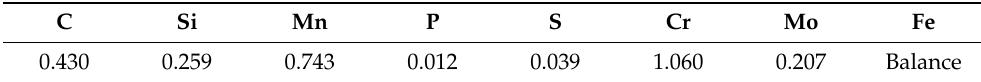
Table 1. Chemical composition of the test material in